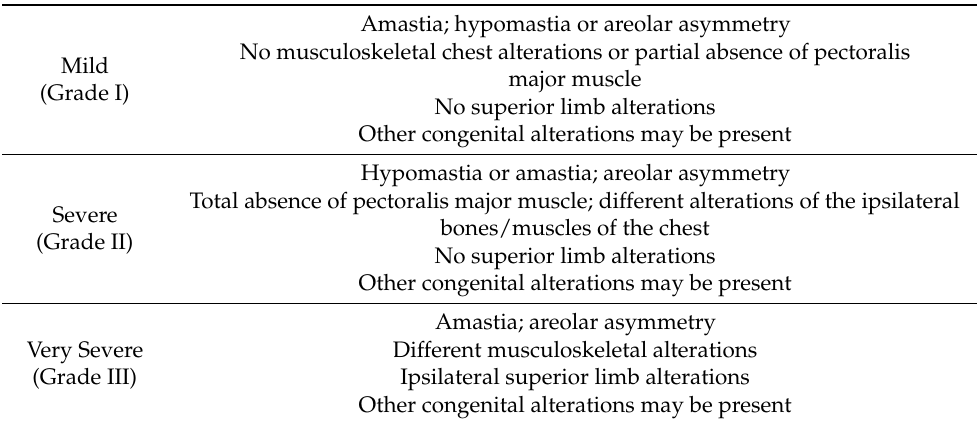
Table 1. Poland Syndrome Classification (modified from Ribeiro et al.